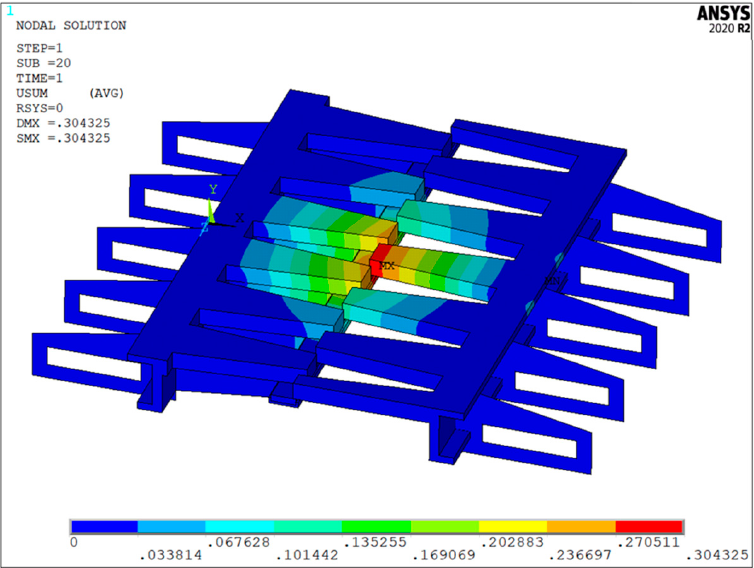
Figure 10. Maximum total deformation diagram of the structure under the working condition II.